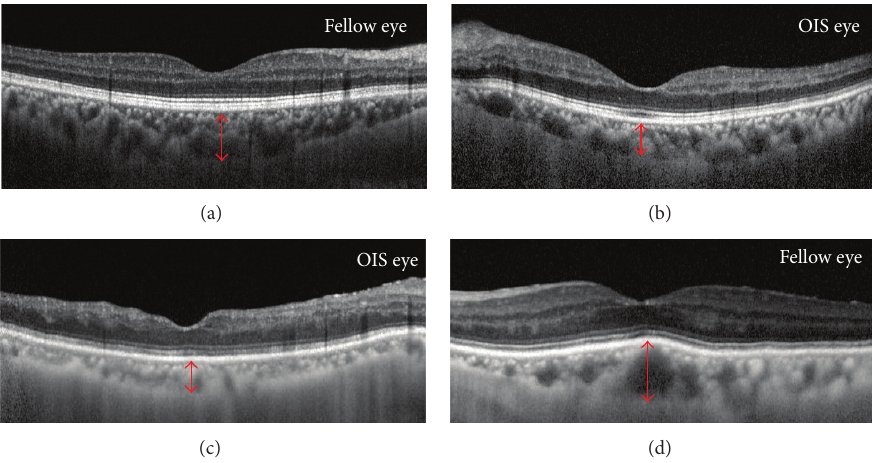
Figure 2: Optical coherent tomography (OCT) findings, choroidal volume, and fundus image of ocular ischemic syndrome (OIS) and fellow eyes. A 59-year-old man had unilateral OIS in the left eye (a, b). The visual acuity of his right and left eye was 1.0 and 0.4, respectively. The subfoveal choroidal thickness (SFChT) of the OIS eye (b) and fellow eye (a) was 204 𝜇 m and 302 𝜇 m, respectively. An 82-year-old man had unilateral OIS in the right eye (c, d). The visual acuity of his right and left eye was counting finger and 0.4, respectively. The subfoveal choroidal thickness (SFChT) of the OIS eye (c) and fellow eye (d) was 155 𝜇 m and 279 𝜇 m, respectively.